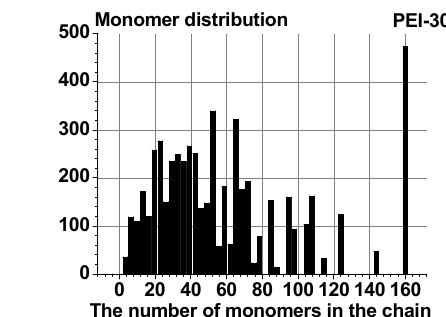
Figure 1. The bar graph of the distribution of monomers in chains of different lengths in Ultem ( left ) and polyetherimide (PEI)-304 ( right ), averaging on all 32 samples.